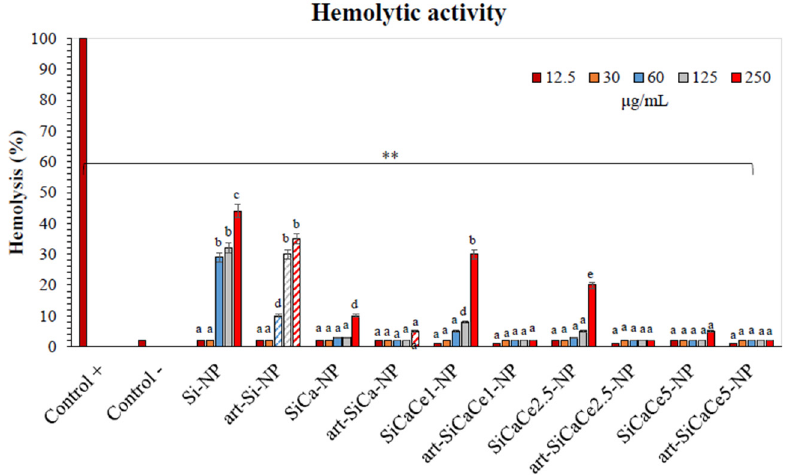
Figure 7. Hemocompatibility assay of NPs and ART-loaded NPs after 60 min of incubation at 37 ◦ C). ** indicates statistically significant difference ( p < 0.001) between treated cells and untreated (controls), while different letters suggest statistically significant differences ( p < 0.001) among con- centrations.